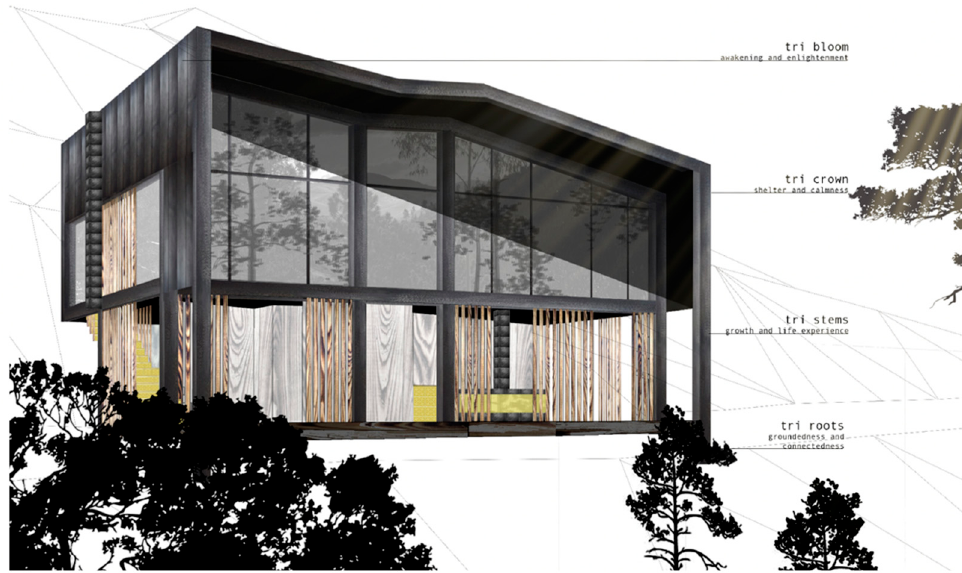
Figure 7. Tri Shala’s atmosphere (second dimension of the design) (Source: compiled by the author). The stems growing through the forest thicket can be experienced on Tri Shala’s ground floor (Figure 8a). This floor is open to its surroundings and gives the feeling of strolling through a forest thicket with its mysteries and prospects. Due to its openness, the floor grounds into the earth, building a stable base for inner growth and a connectedness to the earth.